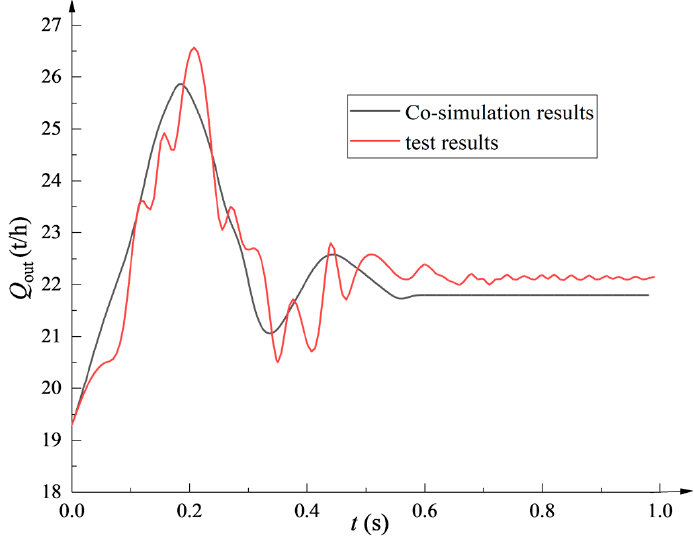
Figure 15. Comparison of dynamic characteristics between co-simulation and experiment.